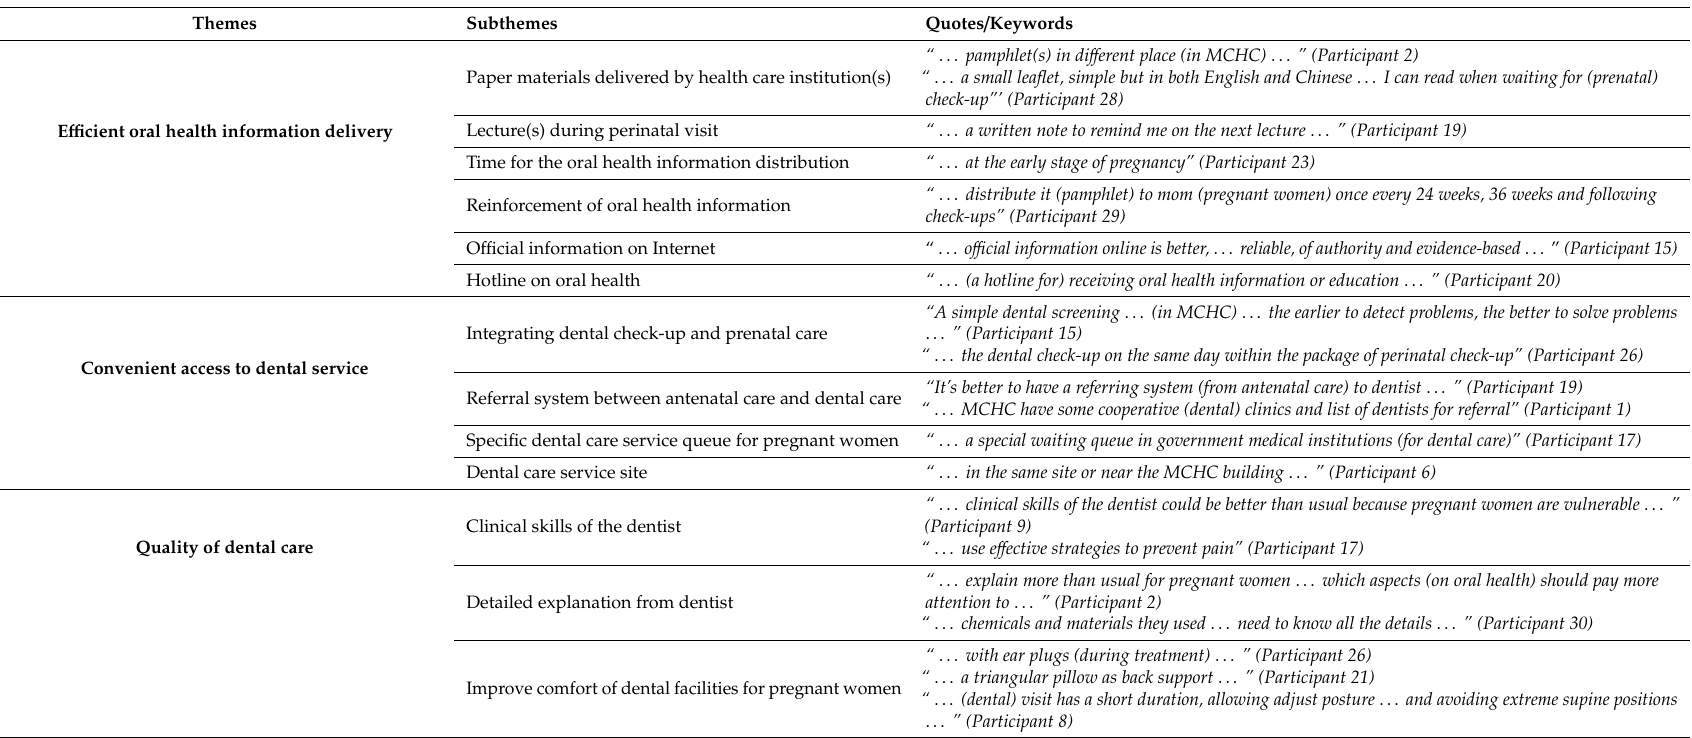
Table 3. Women’s expectation and suggestion on dental care during